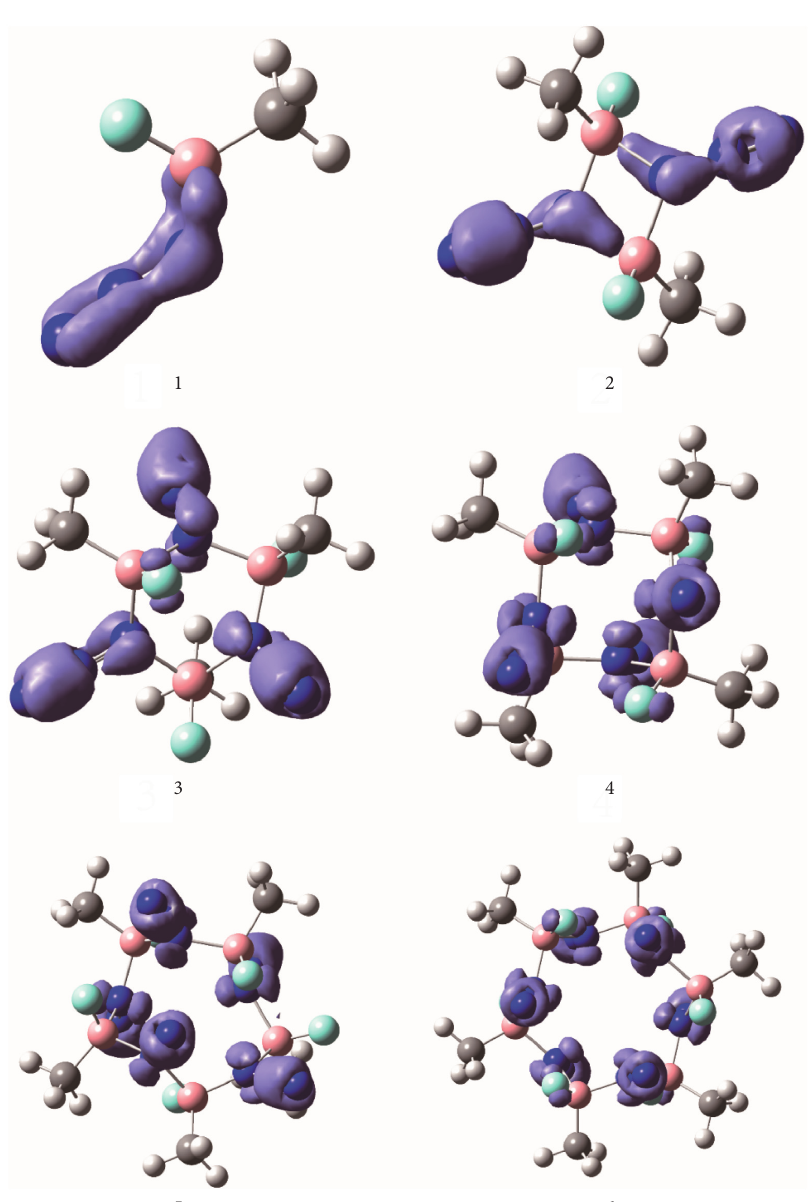
Figure 5: LOL- π isosurface of different systems with the isovalue of 0.4.